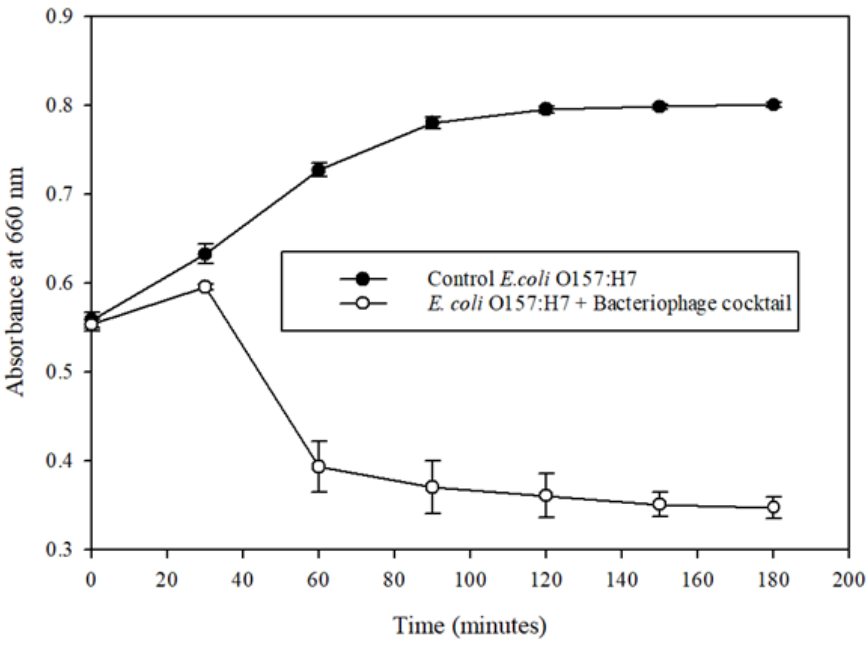
Figure 2. Microplate growth inhibition assay shows a bacteriophage cocktail against Escherichia coli O157:H7 ( E. coli O157:H7) (ATCC 35150) in the presence of organic load. The data points represent the means of triplicate replication, and the error bars represent the standard deviations of three independent experiments. The bacteriophage cocktail reduced the population of E. coli O157:H7 (ATCC 35150) significantly ( p < 0.05) compared to the control.